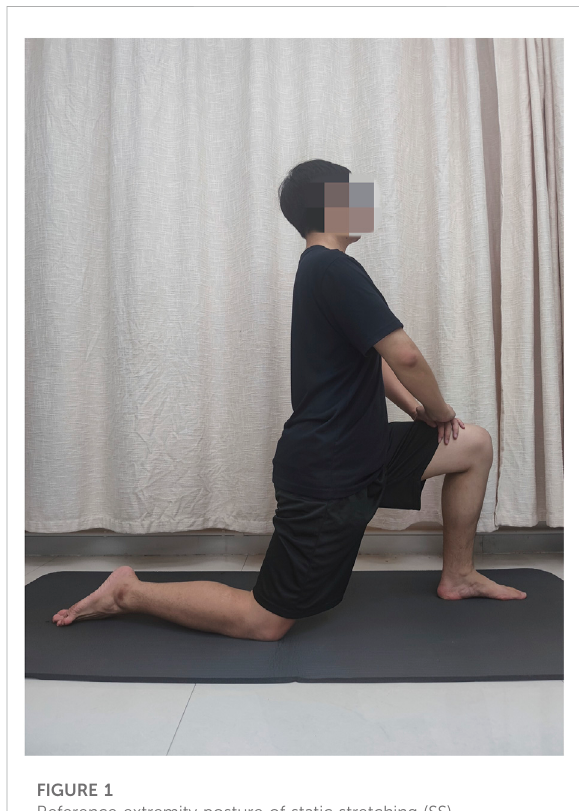
FIGURE 1 Reference extremity posture of static stretching